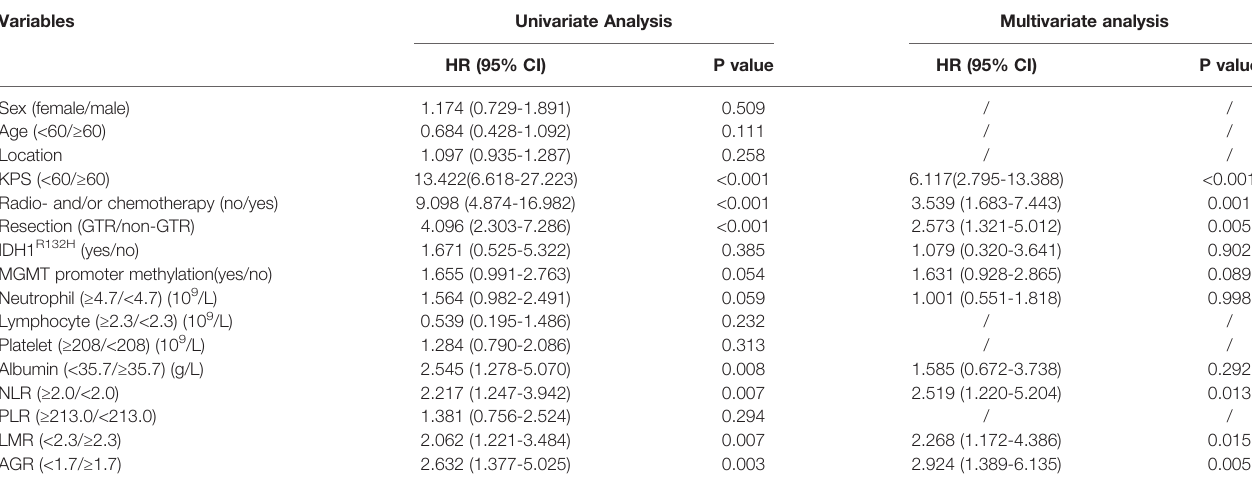
TABLE 2 | Univariate and multivariate analyses of OS in GBM cohorts. Variables